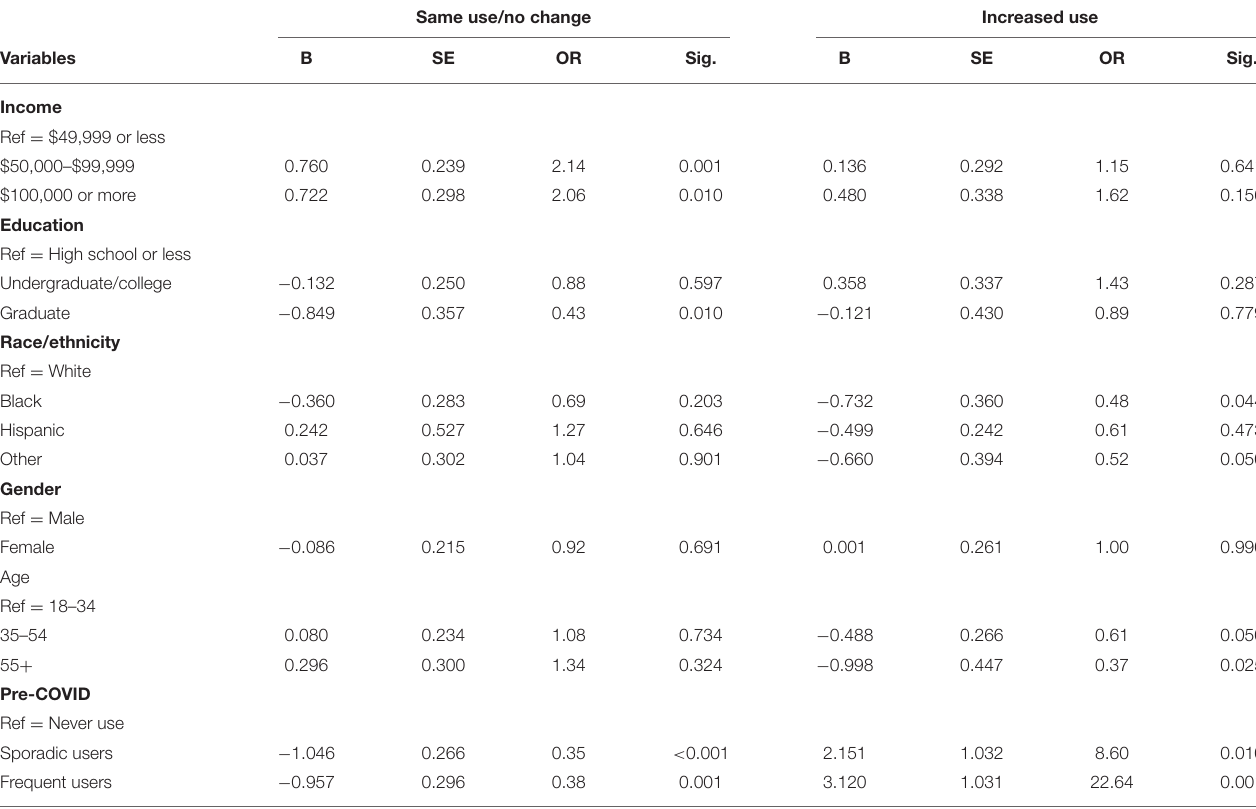
TABLE 3 | Results of a multinomial logistic regression model a predicting demographic variables associated with changes in park use (increasing use or same use relative to stopping/decreasing use) among urban residents ( n = 611) in North Carolina (NC), USA, during the COVID-19 pandemic. Same use/no change Increased use Variables B SE OR Sig. B SE OR